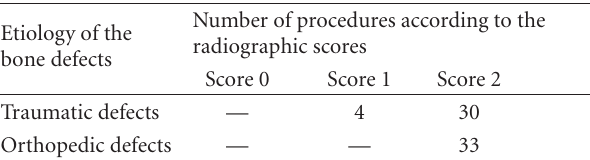
Table 5: Results of the radiographic analysis according to the etiology of the bone defects. Most of the patients received score 2, corresponding to the integration of the bioceramics after the first surgical